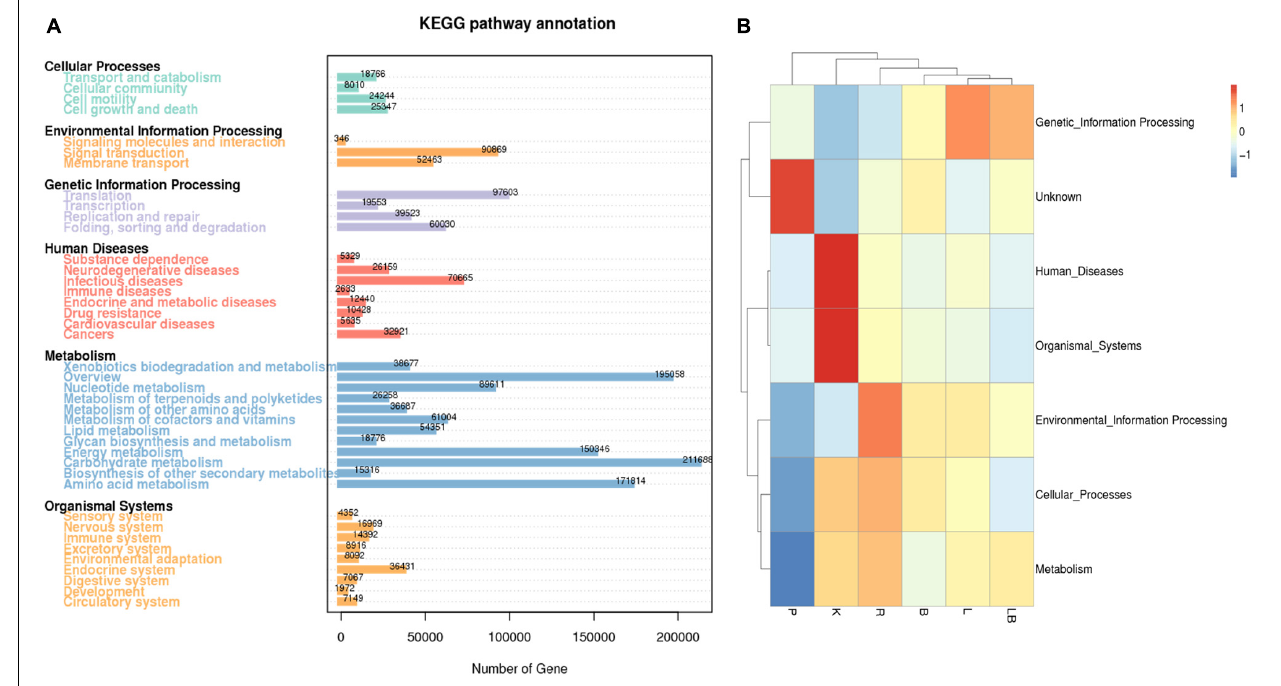
FIGURE 4 | Kyoto Encyclopedia of Genes and Genomes (KEGG) pathway and functional annotation analysis of freshwater benthic biofilm samples. (A) Number of genes annotated to KEGG database at level 2 in the combined column- and organic isolation-based groups. X -axis indicates the number of genes annotated in each KEGG pathway; Y -axis indicates the name of KEGG level 2 pathways. (B) Functional annotation analysis of the relative abundances in the six extraction groups, based on KEGG database level I including 6 pathways. Abbreviations of extraction groups denote, K: Column-based kit isolation; R: RNAzol only group; B: Bead-beating group; L: Lysozyme group; P: Cell disruption bomb; LB: Lysozyme + Bead-beating